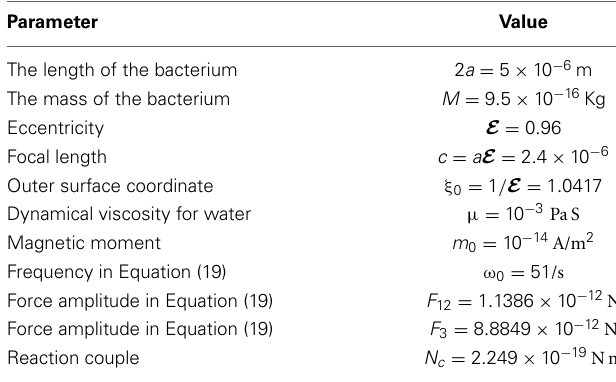
Table 2 | The values of physical/model parameters for the rod-shaped magnetotactic bacteria used in our